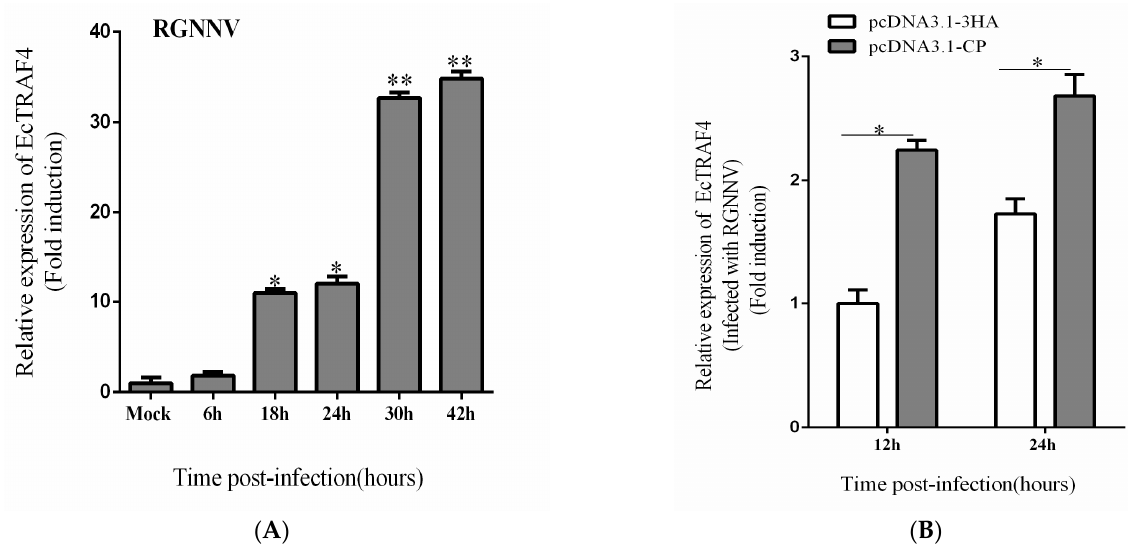
Figure 8. RGNNV and CP promoted EcTRAF4 expression. ( A ) Expression changes of EcTRAF4 in RGNNV-infected cells (means ± S.E., n = 3). β -actin was used as the internal control. Statistical difference is with mock. ( B ) EcTRAF4 mRNA in CP-expressing GS. GS were transfected with CP. TRAF4 mRNA expression was analyzed by RT–qPCR at 12 and 24 h. Scheme 3. 1-3HA-transfected cell. Asterisk denotes a significant difference (* p < 0.05 and ** p < 0.01).